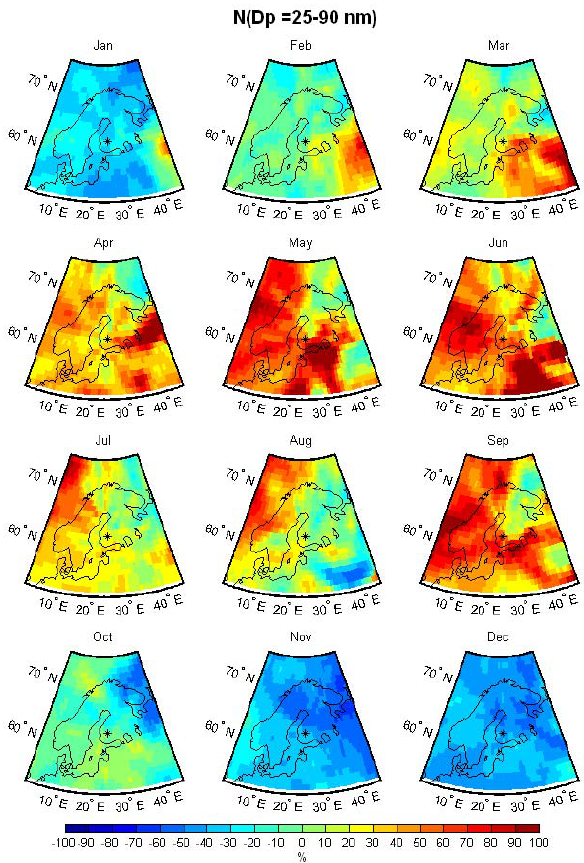
Fig. 6. Deviation from measured average number concentration of Aitken mode particles ( D p = 25–90nm) in Hyyti¨al¨a according to transport directions. Monthly concentration fields are produced for years 1996–2008. Fields are normalized to the geometric mean con- centration (725 cm − 1 ) of the whole measurement period. Hyyti¨al¨a is marked with a